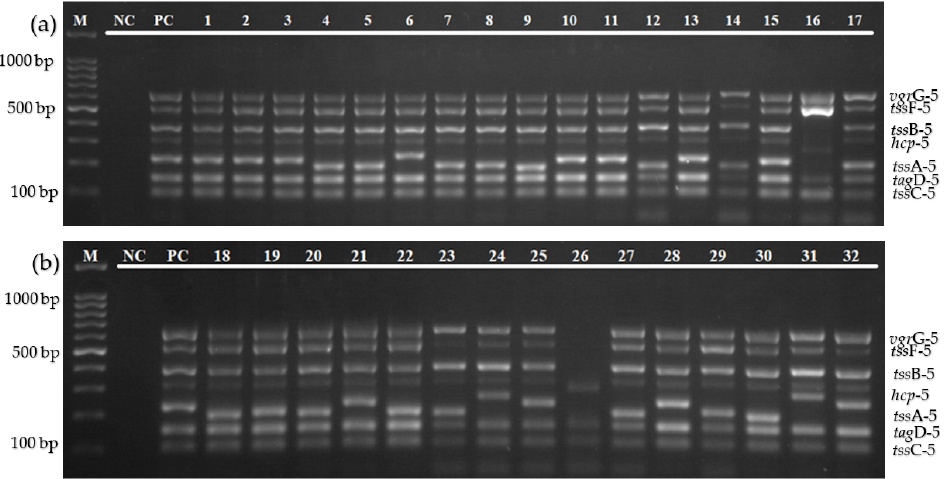
Figure 6. ( a , b ): Evaluation of multiplex PCR using clinical samples. Lane M: 100 bp DNA ladder; NC: negative control; PC: positive control; and lanes 1–32 represent clinical isolates of B. pseudomallei .